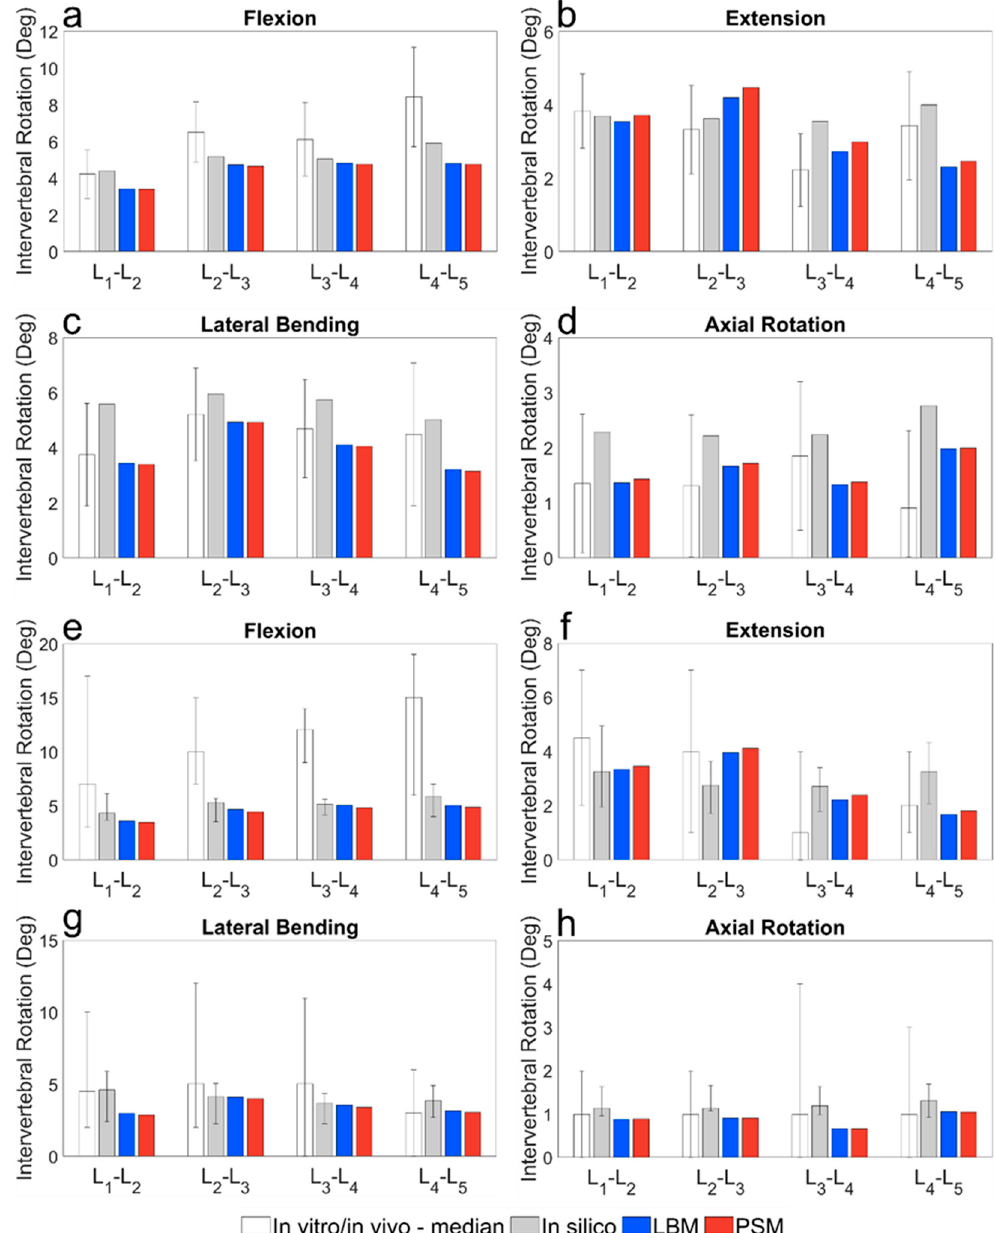
Figure 4. IVR results of the LBM and PSM at different spinal levels. ( a ) Pure bending of 7.5 Nm in flexion, ( b ) extension, ( c ) lateral bending and ( d ) axial rotation. The white bars and their range correspond to the median, minimum and maximum values of an in vitro measurement [60]. The grey bars and their range correspond to the median and range of results of a calibrated FE simulation [29]. ( e ) IVR results of the LBM and PSM at different spinal levels against combined loads in flexion, ( f ) extension, ( g ) lateral bending, and ( h ) axial rotation. The white bars and their range correspond to the median, the minimum, and maximum values of multiple in vivo measurements [53–55]. The grey bars and their range correspond to the median and range of multiple validated FE models result [2].